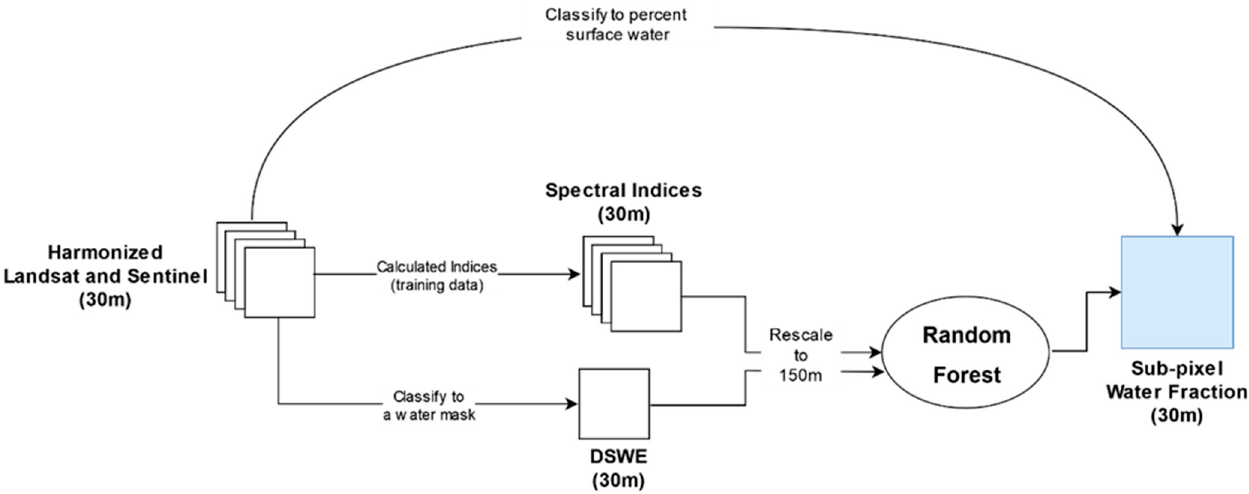
Figure 4. The SWF algorithm (adapted from De Vries et al. [45]). The percent surface water coverage of a pixel is produced at the 30 m scale using a self-trained random forest model of 500 trees. The random forest model is trained using a set of spectral indices and raw band values from harmonized Landsat and Sentinel data rescaled to the 150 m resolution (the training data), and DSWE reclassified to binary surface water presence/absence rescaled to the 150 m resolution (the predicted variable).